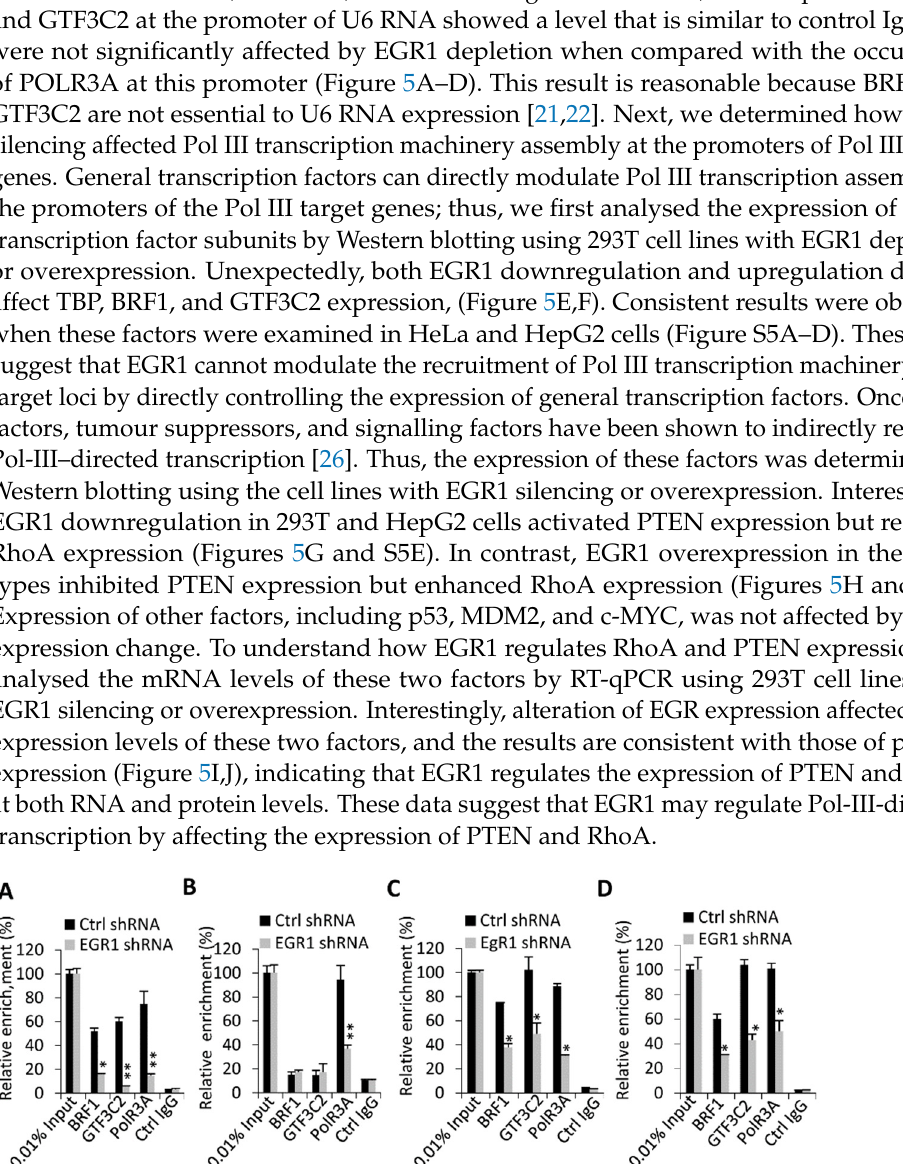
Figure 5 . Alteration of EGR1 expression affected PTEN and RhoA expression: (A-D) ChIP assay results showing the effect of EGR1 on the occupancies of Pol III transcription machinery factors at the promoters of Pol III target genes. ChIP assays were performed using 293T cell lines stably ex- pressing EGR1 shRNA and control shRNA and the antibodies against the factors, as indicated. The relative quantities of the DNA fragments at the loci of 5S rRNA (A), U6 RNA (B), 7SL RNA (C), and tRNA–Met (D) genes were detected by RT-qPCR. Relative enrichment was obtained by comparing the relative DNA quantity in a 1 μ L ChIP DNA sample to that of 0.01% input; (E,F) EGR1 expres- sion change did not affect the expression of TBP, BRF1, and GTF3C2 in 293T cells. Western blotting was performed using 293T cell lines stably expressing EGR1 shRNA (E) and HA–EGR1 (F) and their control cell lines; (G,H) expression of oncogenic proteins, suppressors. and signalling factors in the 293T cell lines with EGR1 depletion (G) or overexpression (H) was examined by Western blotting; (I,J) expression of PTEN and RhoA mNA was monitored by RT-qPCR using the 293T cell line with EGR1 depletion or overexpression. E/G, H/G, P/G, and R/G in Western blot quantification, respectively represent the ratio of EGR1 (E), HA–EGR1(H), PTEN(P), and RhoA (R) intensities to the GAPDH (G) intensity (n = 3). Each column in the bar graphs represents the mean ± SD of three